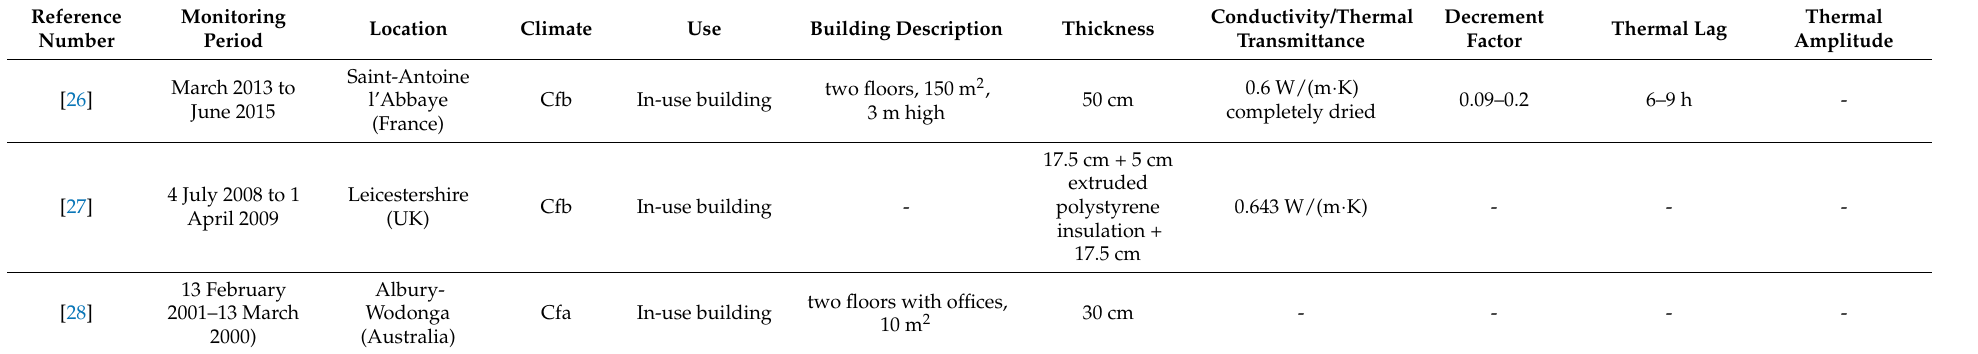
Table 6. Building characteristics and thermal performance of the rammed earth monitored